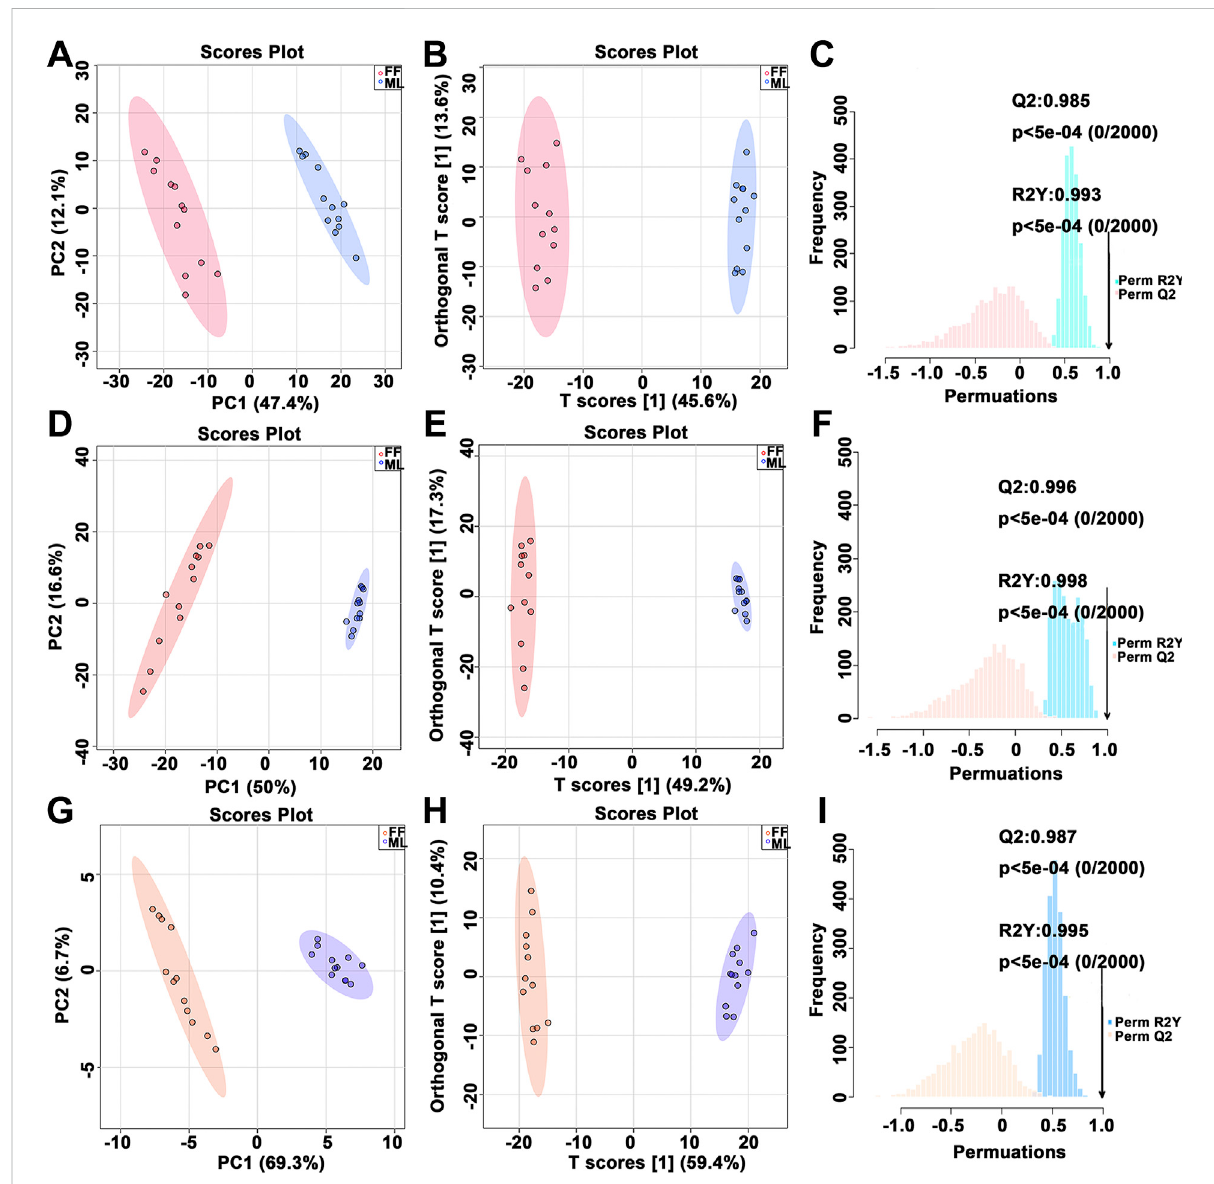
PCA score plot, OPLS-DA score plot and corresponding permutation test results of the metabolite pro fi les. PCA, principal component analysis; OPLS-DA,orthogonalpartialleastsquaresdiscriminantanalysis.PCAscoreplot (A,D,G) ,OPLS-DAscoreplot (B,E,H) andcorrespondingpermutation test results (C,F,I) were derived from the metabolite pro fi les of the midgut (MG, (A – C) , hemolymph (HL, (D – F) and posterior silk gland (PSG, (G – I) . Red dots represent silkworms fed formula feed (FF), and blue dots represent silkworms fed mulberry leaves